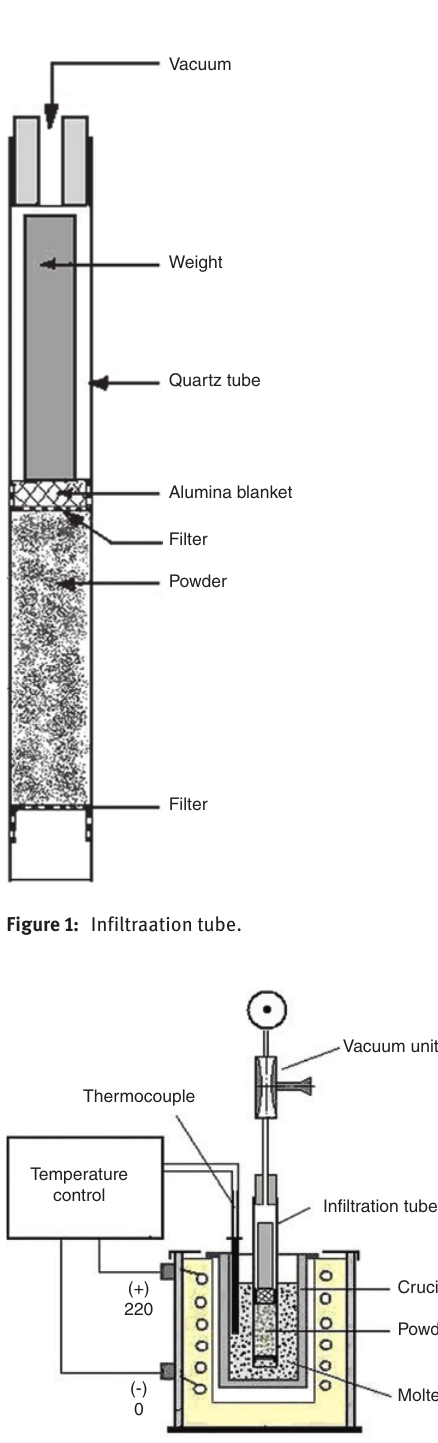
Figure 2: A prototype vacuum infiltration